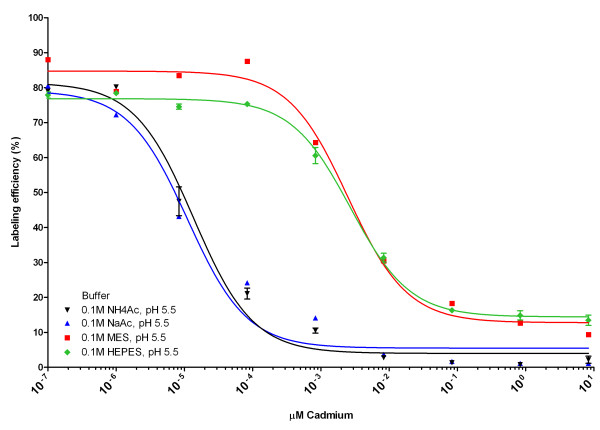
Effect of cadmium on labelling of 111In-DTPA-exendin-3 in 0.1 M NaAc, NH4Ac, MES and HEPES.